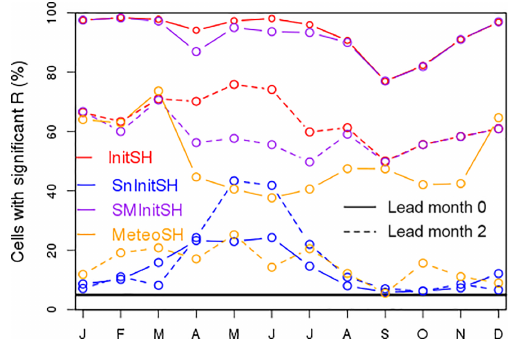
Figure 5. Comparison of the annual cycles of the skill in the run-off hindcasts of four specific hindcasts for lead months 0 and 2. Differ- ent colours correspond to different specific hindcasts, and different line types to different lead